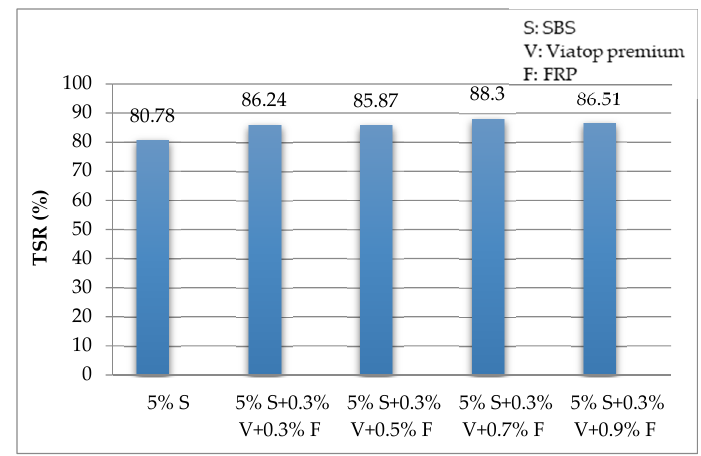
Figure 5. Results of TSR.